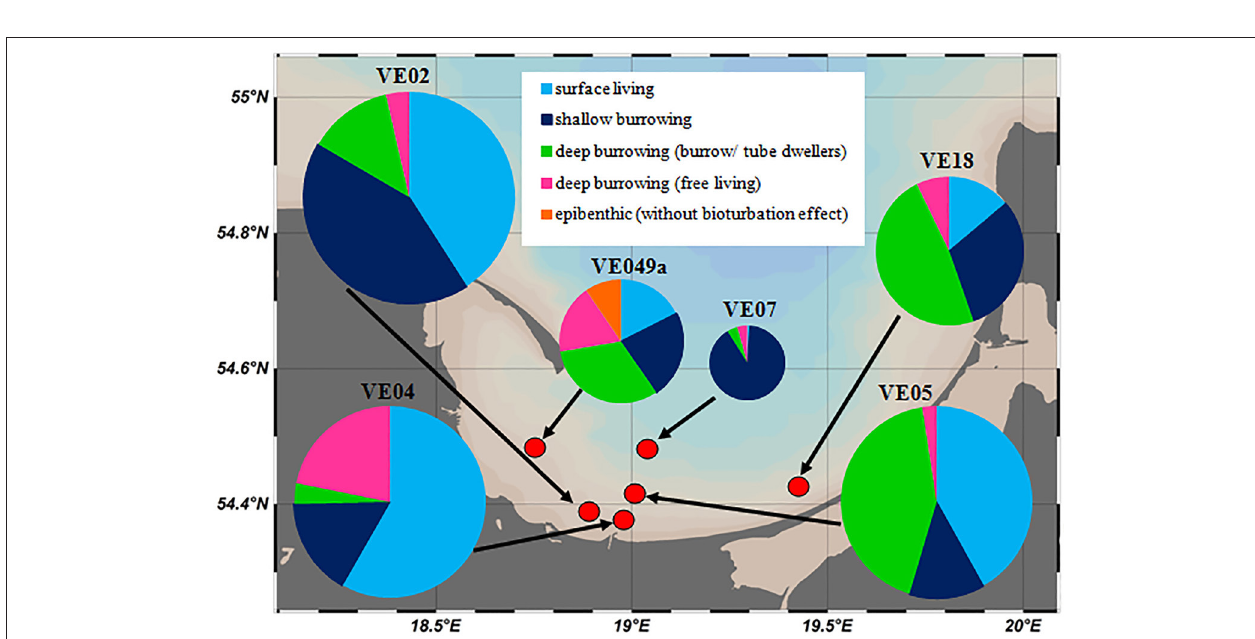
of a greater infauna biomass. Additionally,